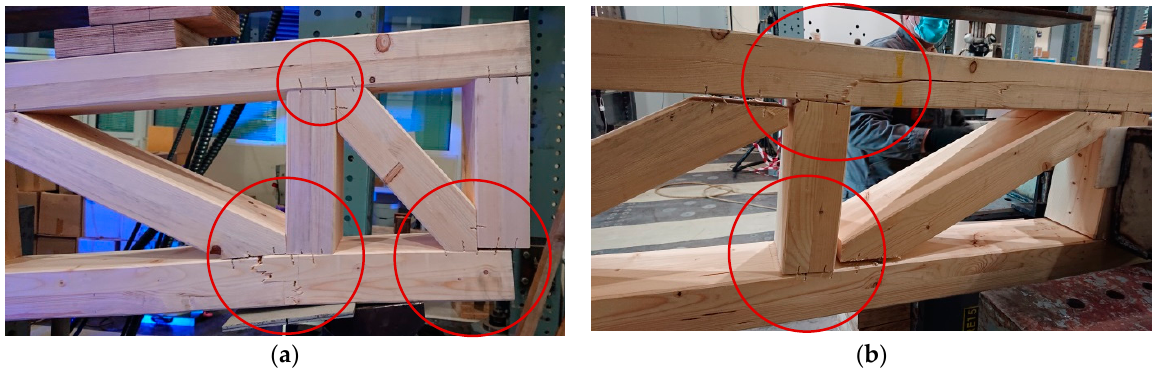
Figure 8. Typical failure and damage mechanisms of beams with no web panels: ( a ) Failure of the bottom flange at vertical stud–flange joint and large deformations of the vertical stud–flange joints; ( b ) Shear failure of the upper flange at vertical stud–flange joint and large deformations of the vertical stud–flange joints.